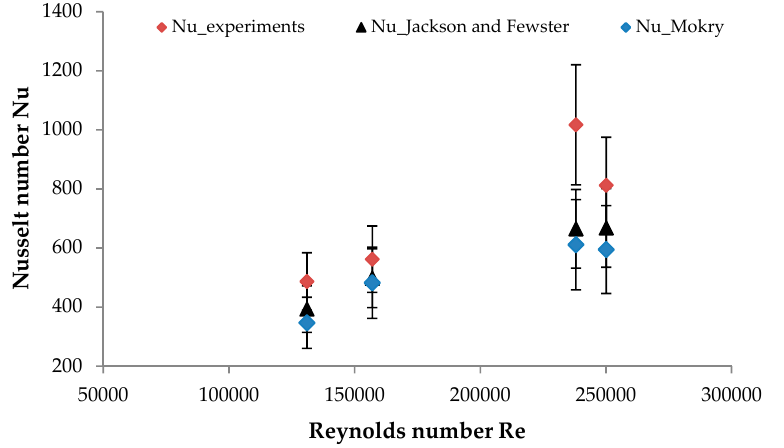
Figure 8. Comparison of the experimental Nu number with the heat transfer correlation from literature obtained at supercritical conditions.